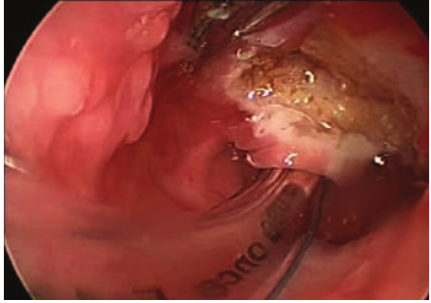
Figure 4: Postoperative endoscopic view of case I.